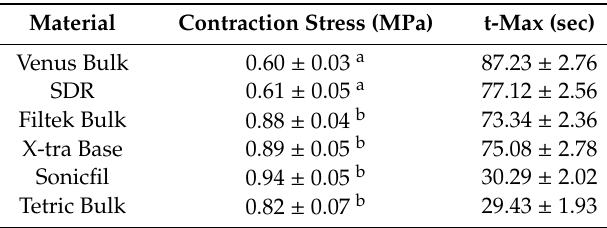
Table 4. Mean values and standard deviation (SD) for shrinkage stress (SS) and time to achieve maximum stress rate (t-Max) of the tested materials. Di ff erent superscript letters indicate significant di ff erence within column ( p < 0.05).